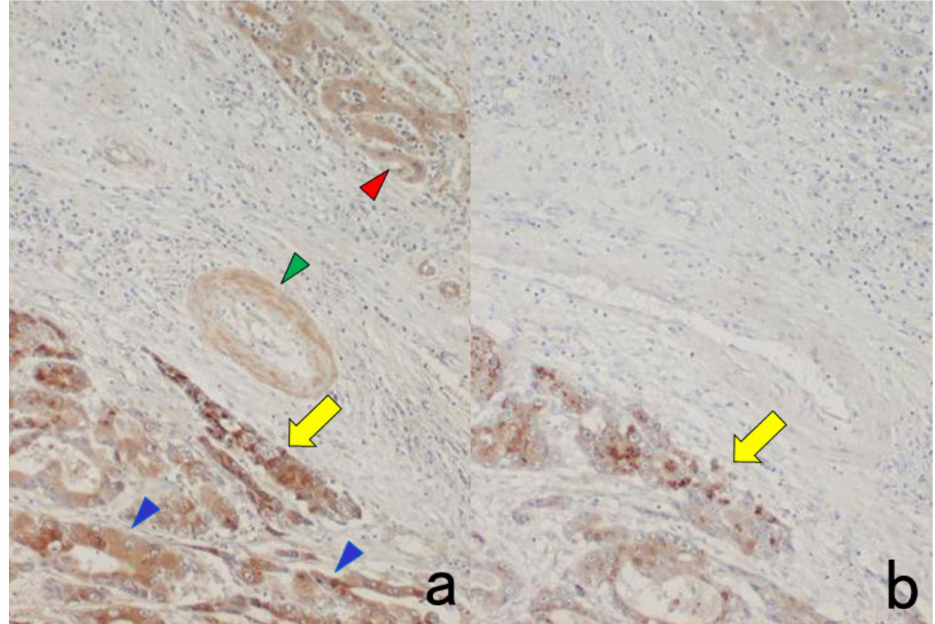
Figure 17. The need for appropriate dilution of the primary rabbit antiserum. Alpha-fetoprotein (AFP) immunostaining (using the polymer method) for hepatocellular carcinoma. ( a ): 1:400 dilution, ( b ): 1:3200 dilution. With 1:400 diluted antiserum, non-neoplastic hepatocytes (blue arrowheads), bile ducts (red arrowhead) and arterial wall (green arrowhead) reveal nonspecific staining. At an appro- priate dilution (1:3200), positive signals of AFP are seen only in the hepatoma cells (yellow arrows). To lower the background noise, the following tips should be